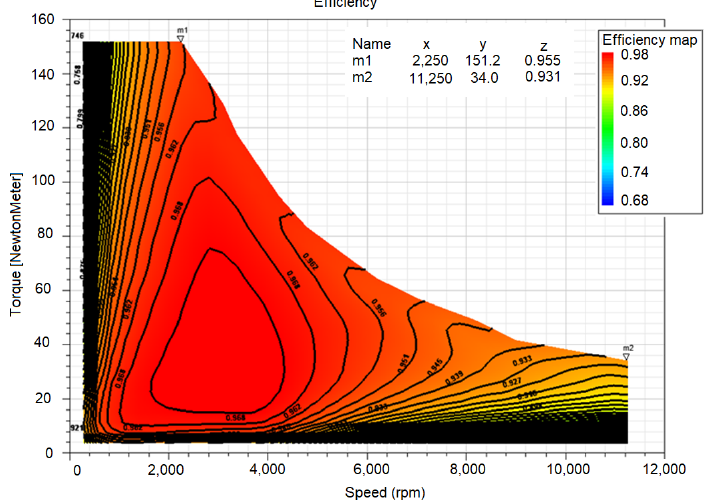
Figure 15. Simulation results for efficiency map.